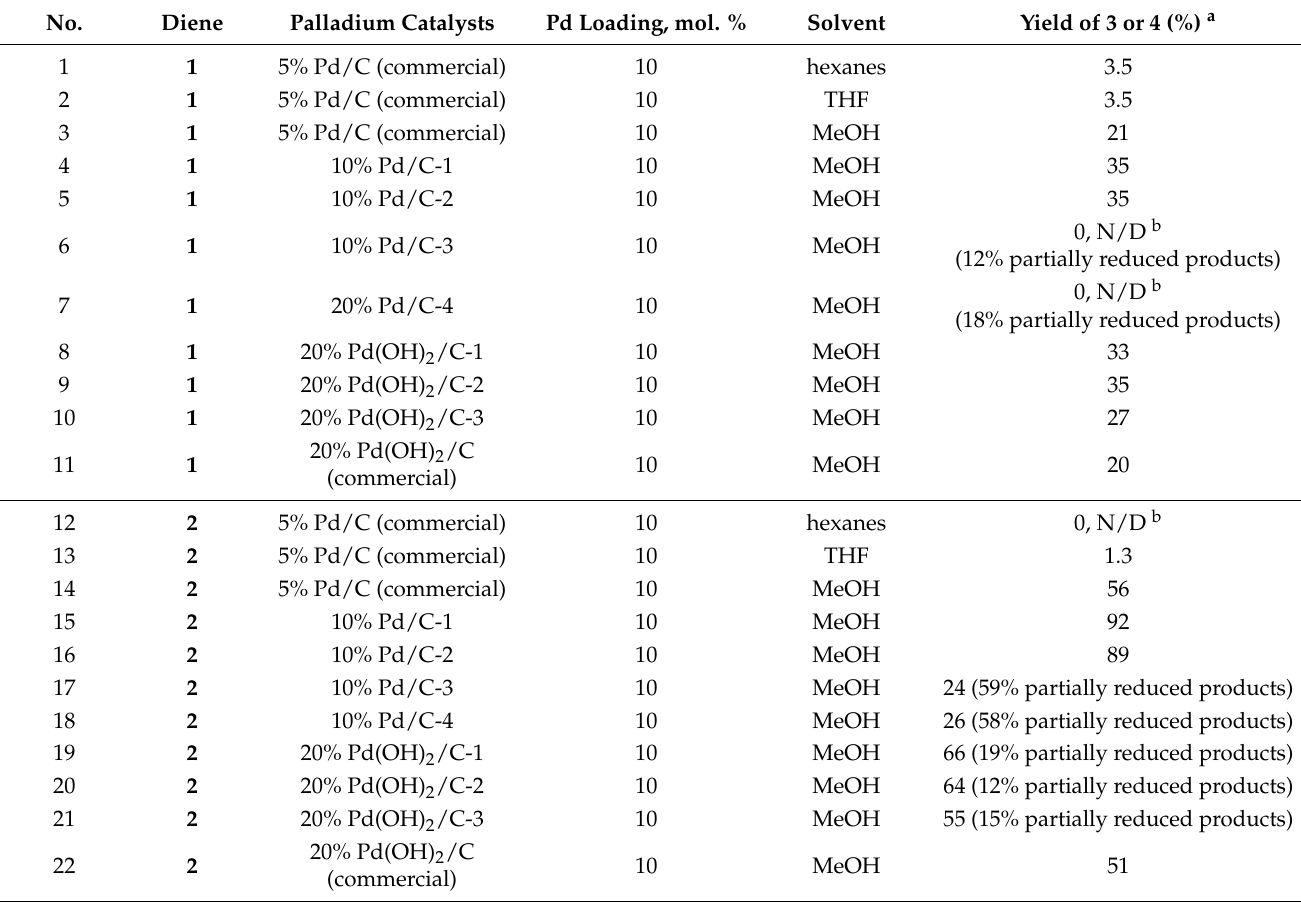
Table 3. Catalytic hydrogenation of dienes 1 and 2 : screening of Palladium